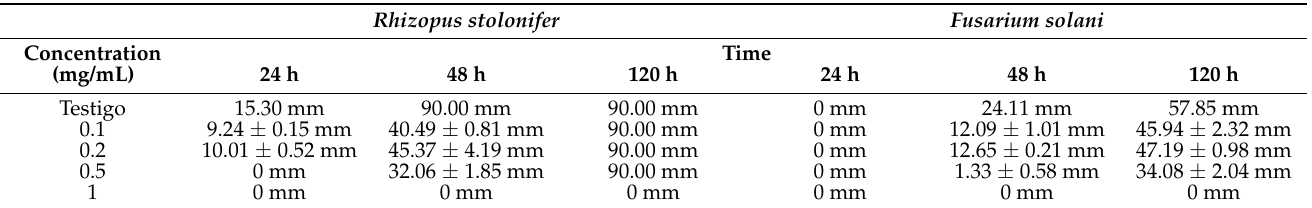
Table 1. Diameter values and standard deviation of the growth of Rhizopus stolonifer and Fusarium solani as a function of time for different concentrations of silver NPs.